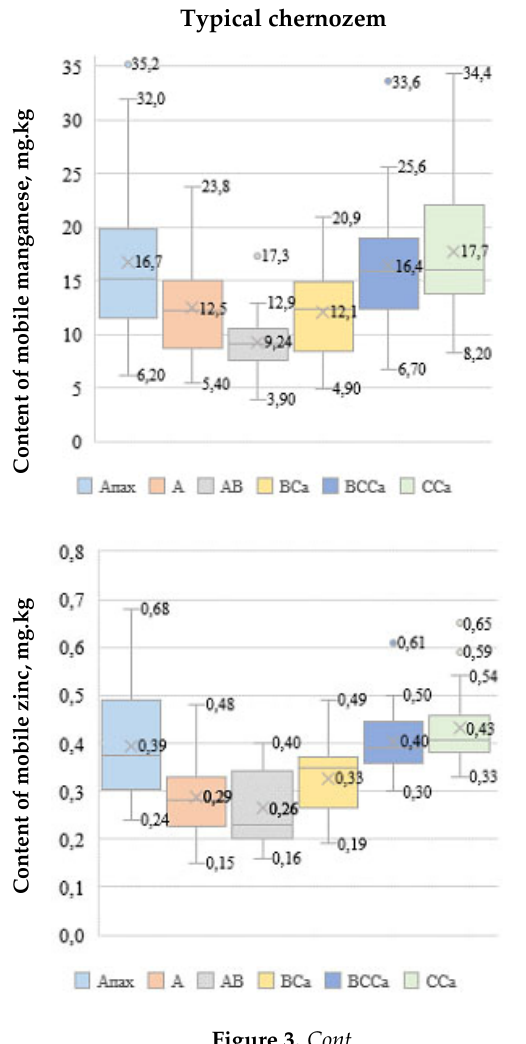
Figure 3. Contents of mobile forms of trace elements in the profiles of typical and ordinary arable chernozems.